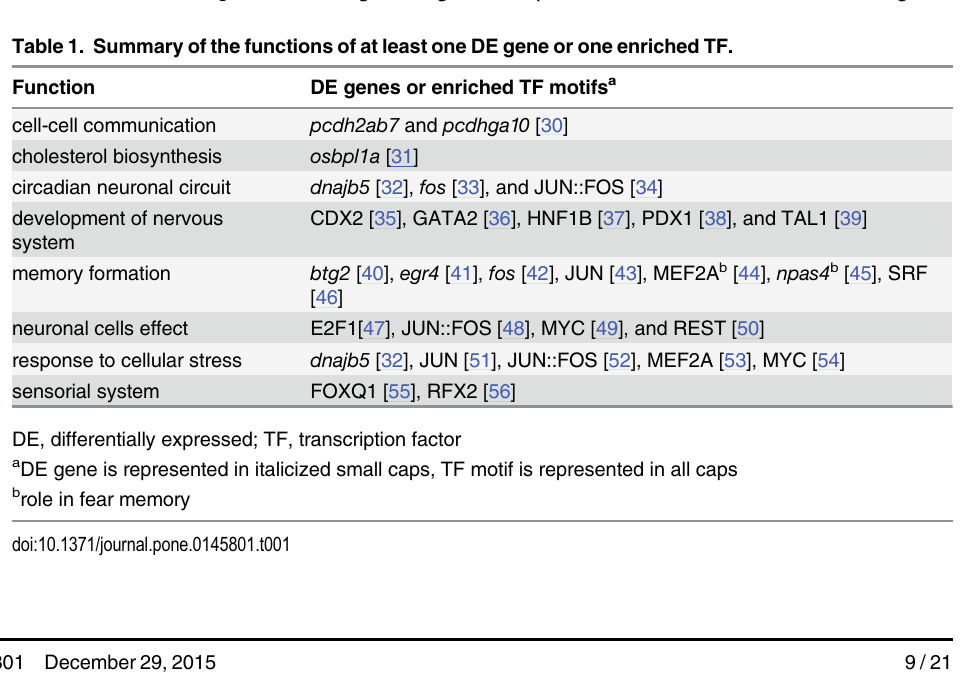
Table 1. Summary of the functions of at least one DE gene or one enriched TF. Function